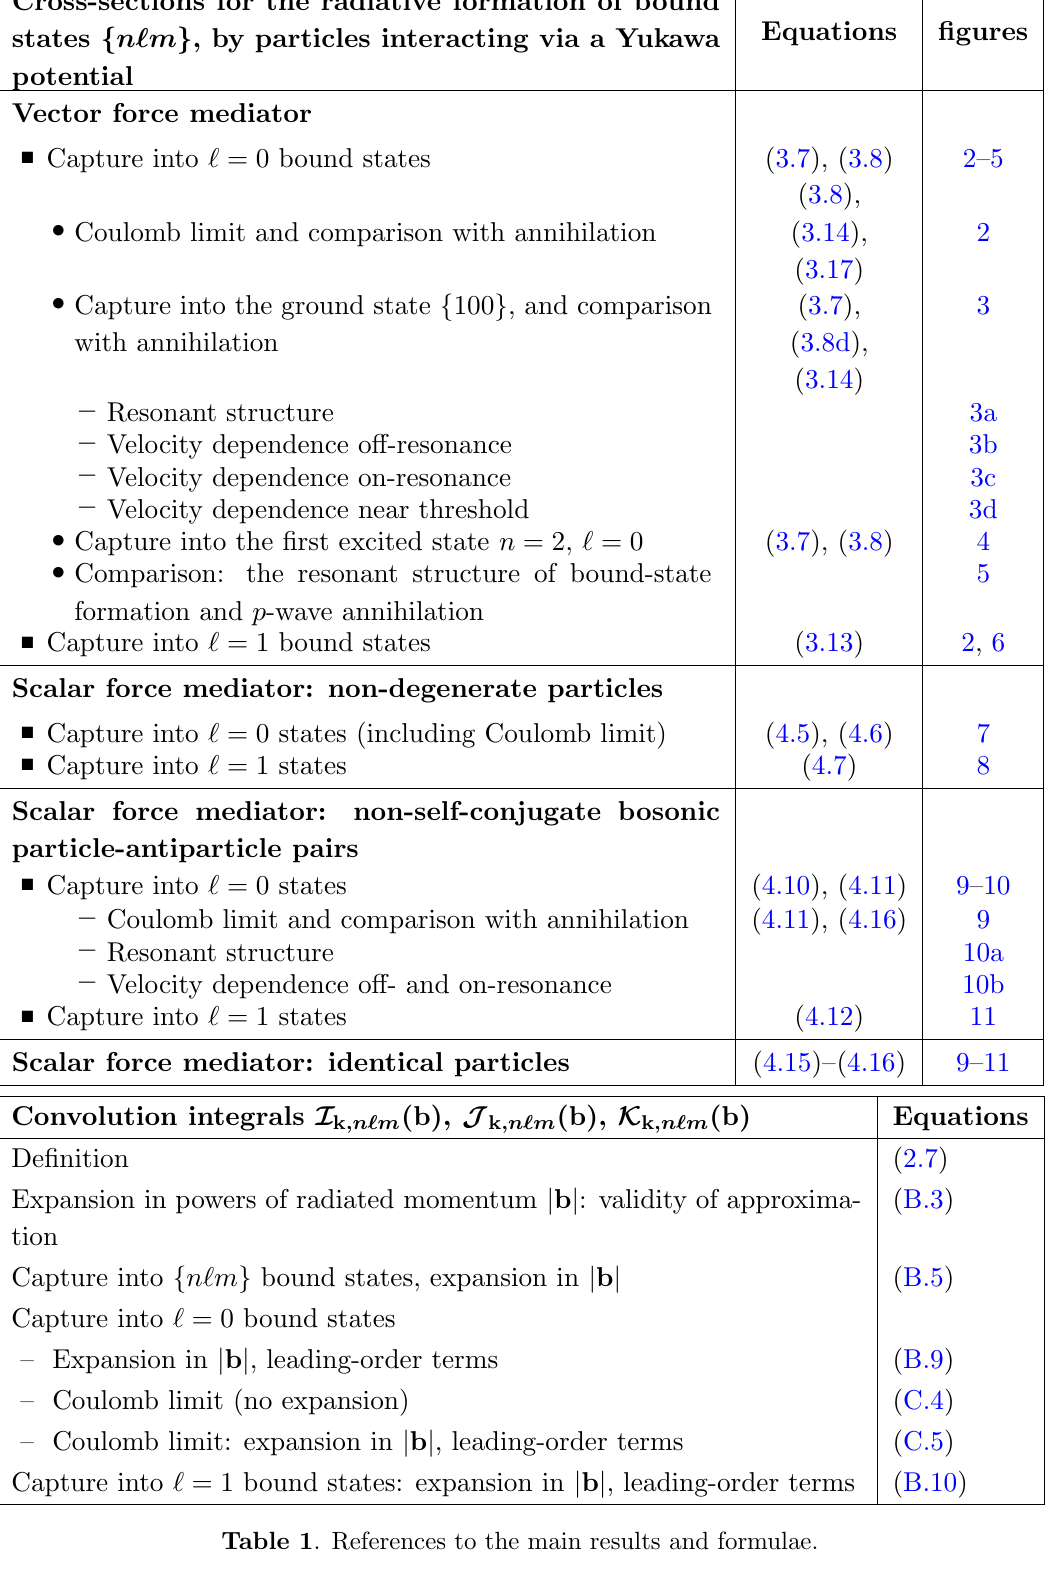
Table 1 . References to the main results and